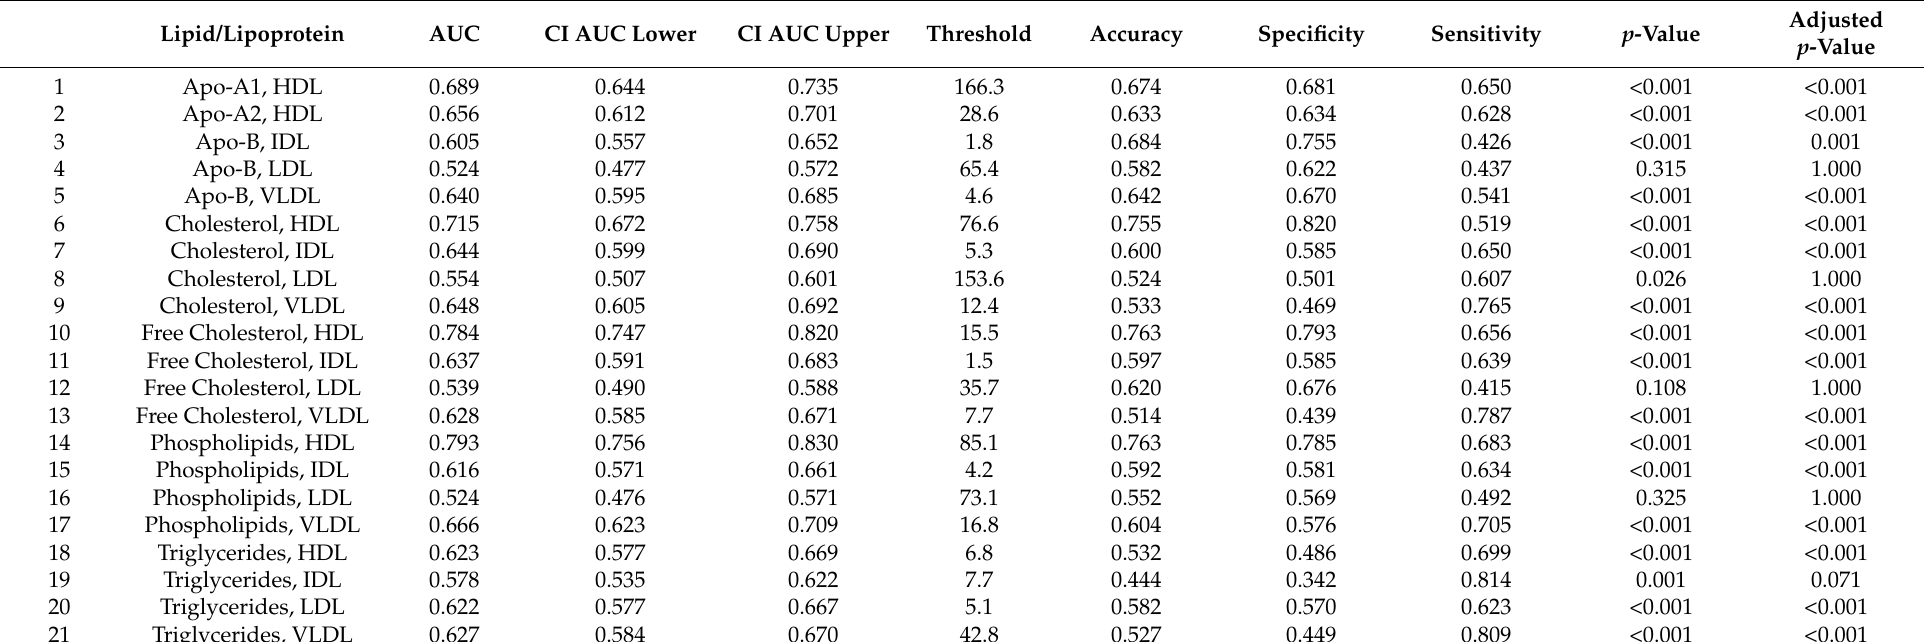
Table 3. ROC analysis of the concentrations of lipoproteins and lipid main fractions in men and women. Age groups are defined in Table 1. Concentrations are in mg/dL. Adj stands for adjusted. CI indicates the 95% Confidence